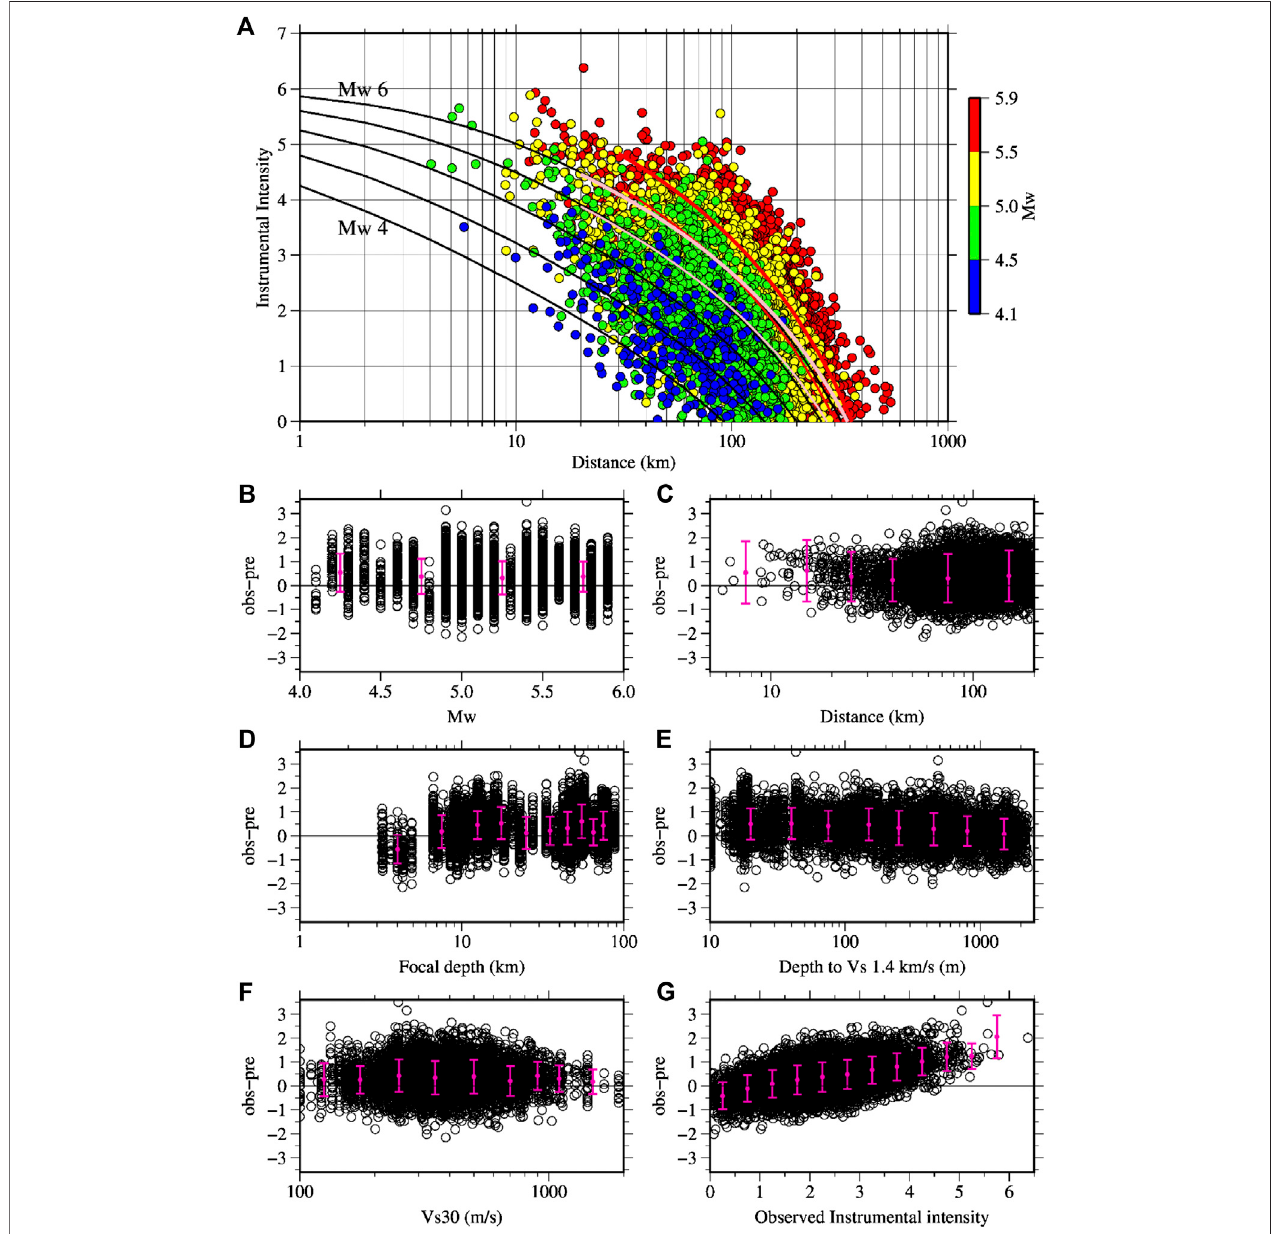
FIGURE 7 | (A) JMA instrumental intensities for the same set of data plotted in Figure 3 . The black lines denote the median prediction curves for crustal earthquakes of Mw (cid:2) 4, 4.5, 5, 5.5, and 6, respectively, using the GMPEs in Morikawa and Fujiwara (2013). The thin and thick pink (red) lines denote the median prediction curves for Mw (cid:2) 5.5 and 6, respectively, for the interplate (intraslab) earthquakes. (B – G) show the distribution of residuals against the Mw, hypocentral distance,focaldepth,depthtoVs1.4 km/s,Vs30,andobservedinstrumentalintensity,respectively.Theverticalbarsdenotethemeanvalueswithplus-minusone standard deviation of the binned